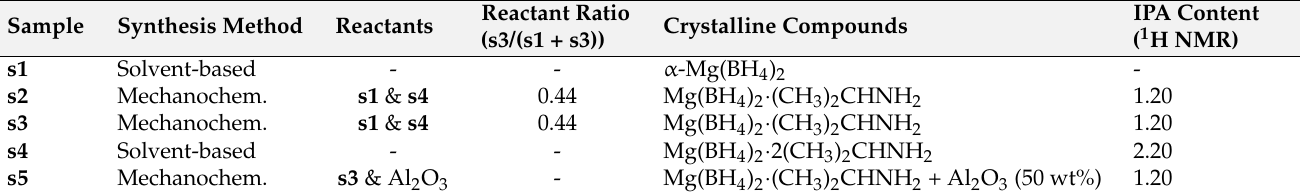
Figure 4. ( a ) Temperature-resolved in situ synchrotron radiation powder X-ray diffraction of Mg(BH 4 ) 2 ∙ 1.20IPA ( s3 ) from 20 to 75 °C (heating rate of 2 °C/min). ( b , c ) Selected diffraction patterns at 46 and 22 °C, respectively. The data were acquired at the I11 beamline of the Diamond light source ( λ = 0.826366 Å). Table 1. Overview of the investigated samples including synthesis method, molar reactant ratios, crystalline compounds observed in the product using powder X-ray diffraction, and the (CH 3 ) 2 CHNH 2 content as measured by liquid-state 1 H nuclear magnetic resonance.